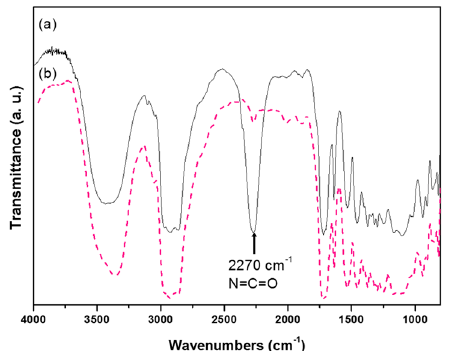
Figure 4. IR spectrum of polyurethane (FMEP-PU) ( a ) before mixing with the capping agent and ( b ) after 3 h of mixing with the capping agent.